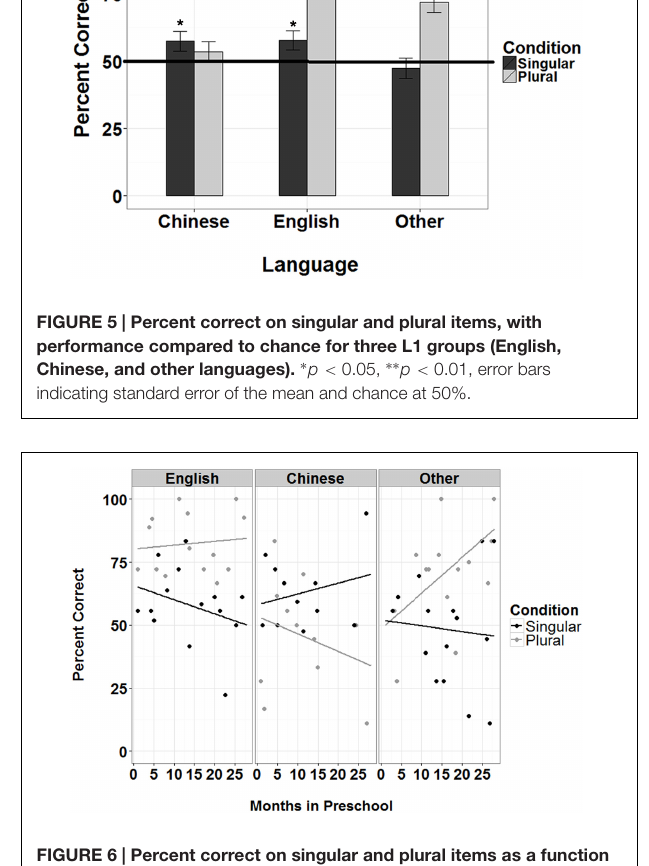
FIGURE 6 | Percent correct on singular and plural items as a function of months spent in Preschool for three L1 groups (English, Chinese, and other